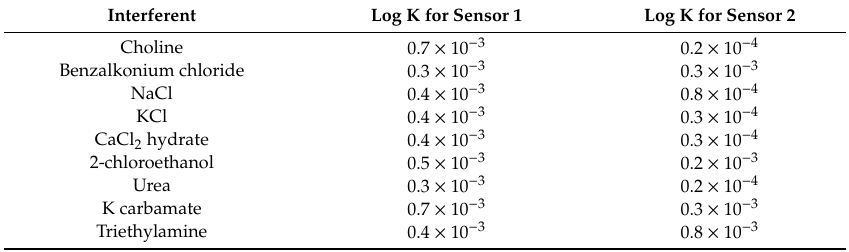
Table 3. Potentiometric selectivity coe ffi cients (Log K pot carbachol, interferent ) for the proposed sensors.